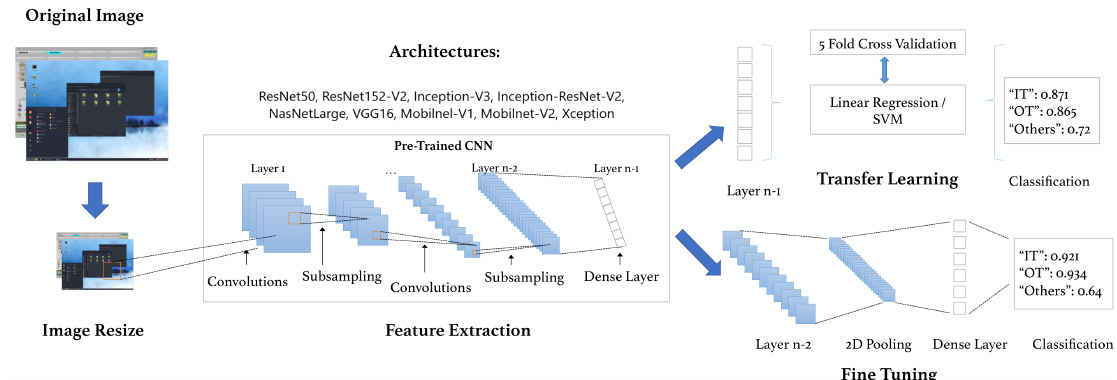
Figure 2. Transfer learning and fine-tuning pipeline. Transfer learning and fine-tuning were used to train classifiers and output the final